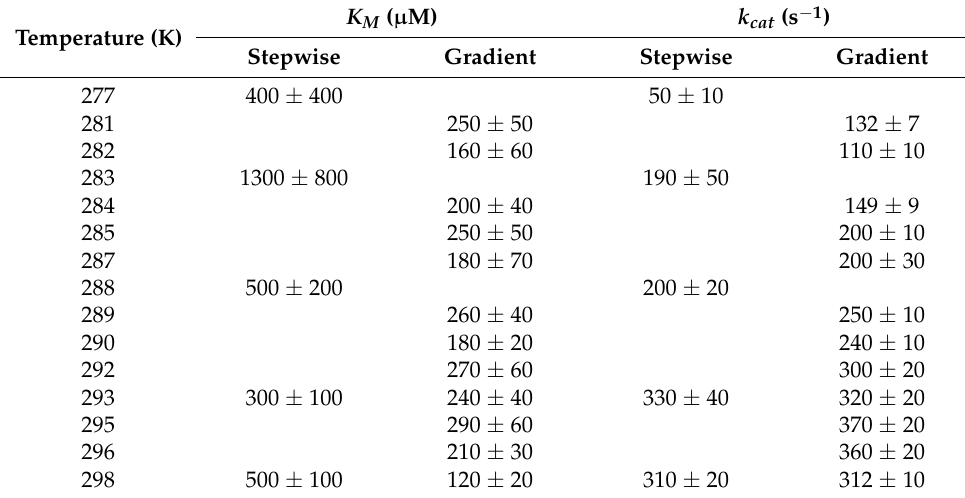
Table 1. Steady-state Michaelis–Menten parameters for pLipA with the substrate para-nitrophenyl butyrate determined using a traditional stepwise approach and our new gradient approach (Ther- moSlope).